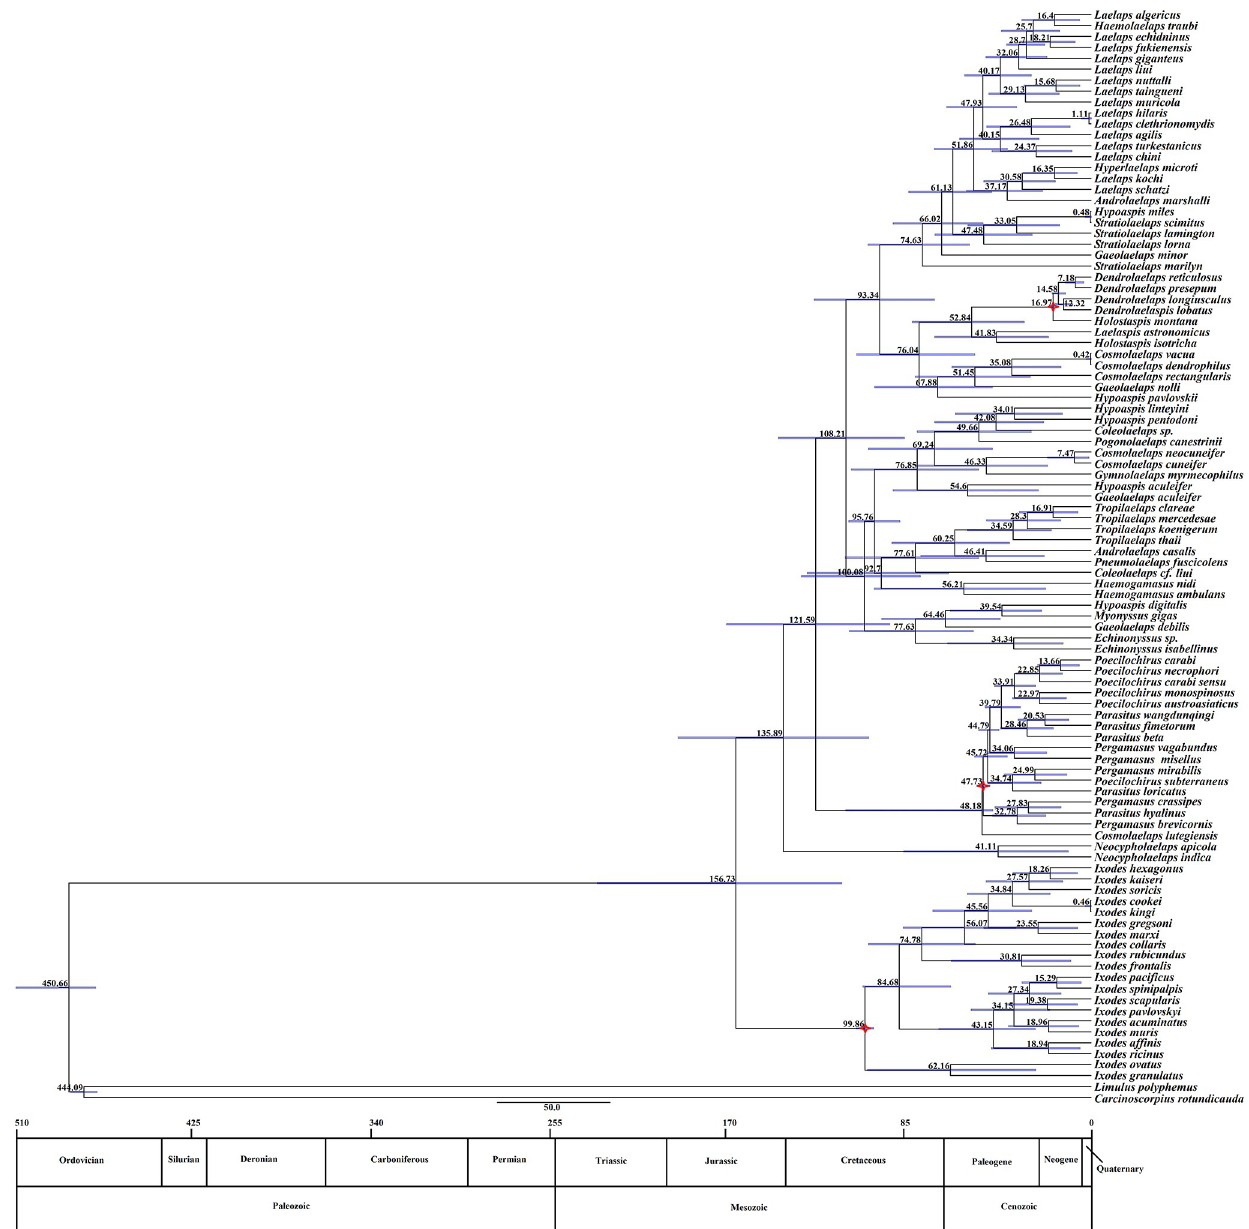
Fig 4. Estimation of the divergence time of the family Laelapidae. (Blue horizontal bars at nodes represent 95% confidence intervals; red star indicates each node calibrated using fossil constraints; numbers on the branches represent the years of divergence, unit: million years).